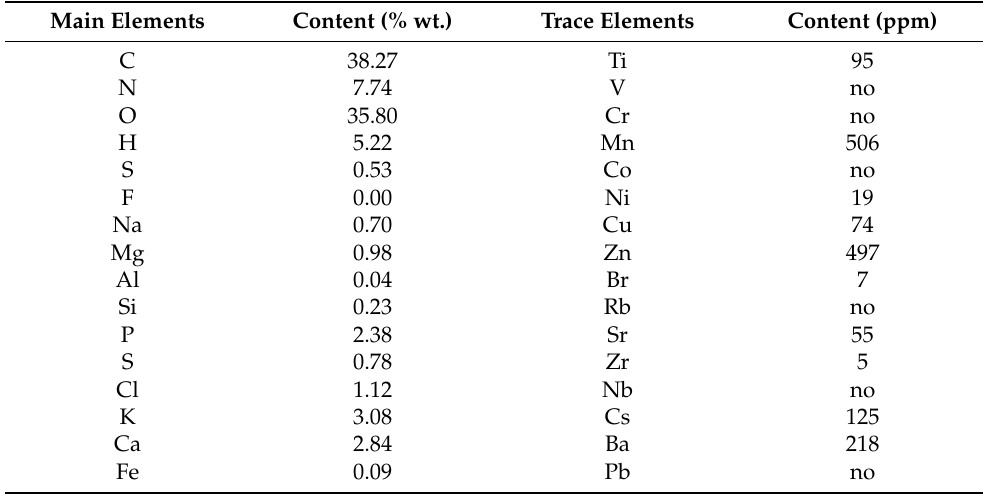
Table 3. Chemical composition of the poultry manure samples taken (on a dry basis).